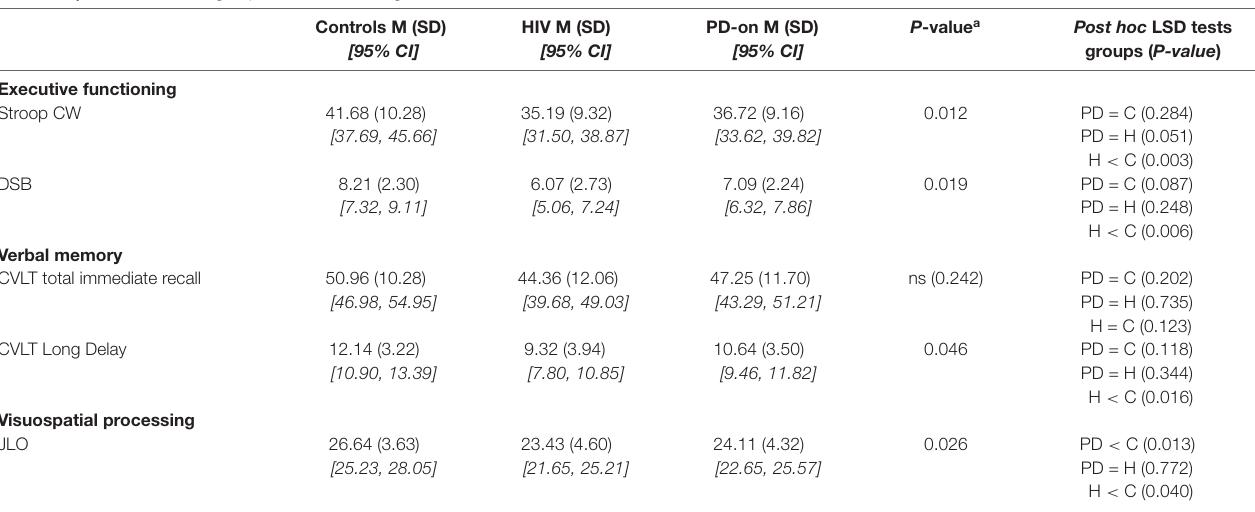
TABLE 1 | Raw scores and group differences for cognitive